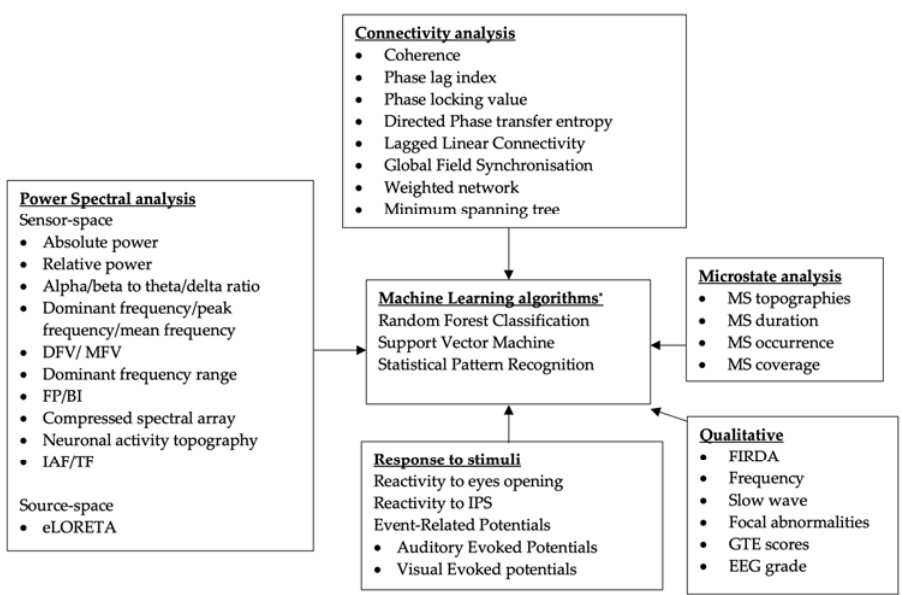
Figure 2. Classification of EEG parameters and analyses in the included studies. * Not a quantitative EEG analysis, may include other biomarkers as features. BI = band inscription; DF = dominant frequency; DFV = dominant frequency variability; eLORETA = exact low resolution brain electromagnetic tomography; FIRDA = frontal intermittent rhythmic delta activities; FP = frequency prevalence; GTE = grand total EEG score; IAF = individual alpha frequency peak; IPS = intermittent photic stimulation; MFV = mean frequency variability; MS, microstate; TF = transition frequency.